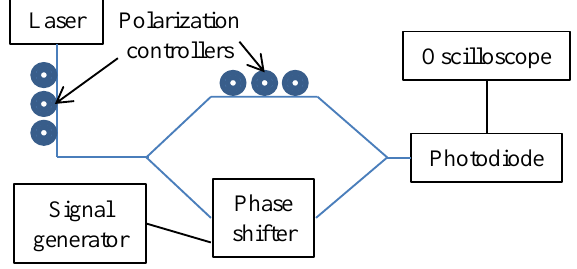
Figure 5. Diagram of the set-up for the study of the EO